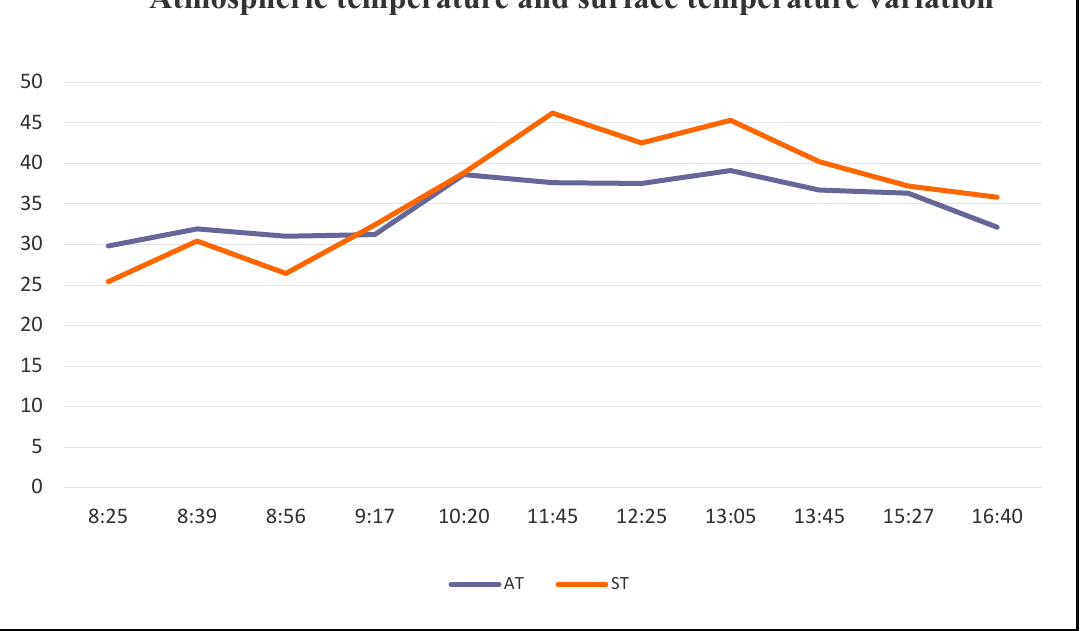
Figure 5. Variation between atmospheric temperature (AT) and land surface temperature (ST) on 29 March 2019.